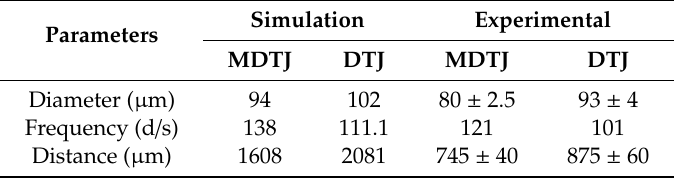
Table 1. Comparison between experimental and simulation for both MDTJ and DTJ in